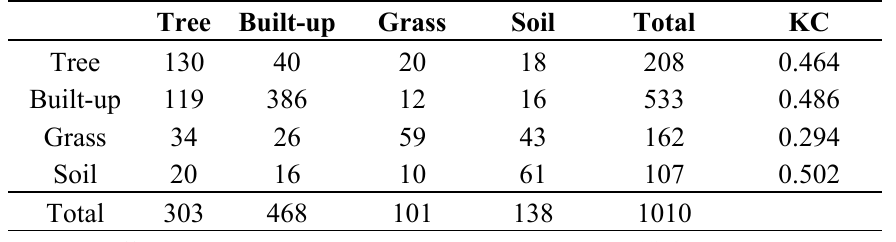
Table 6. Confusion matrix of the classification results using original LiDAR